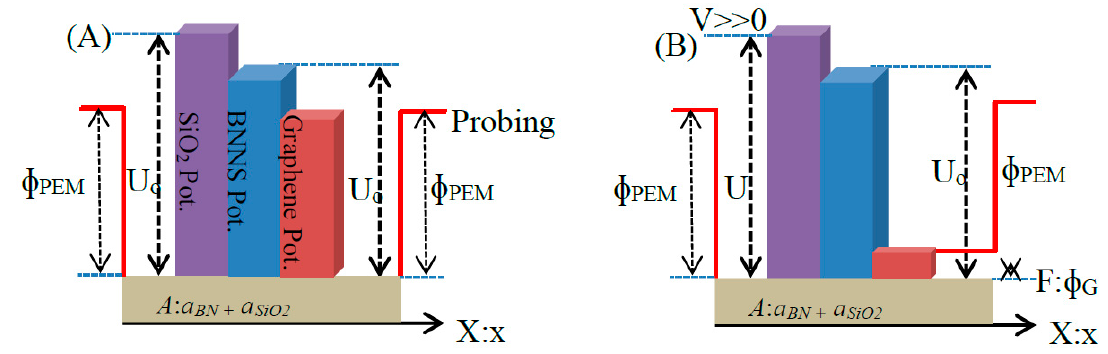
Schematic representation of potential barriers for ( a ) G / BNNS / SiO 2 and ( b ) PEM / G / BNNS / SiO 2 systems.